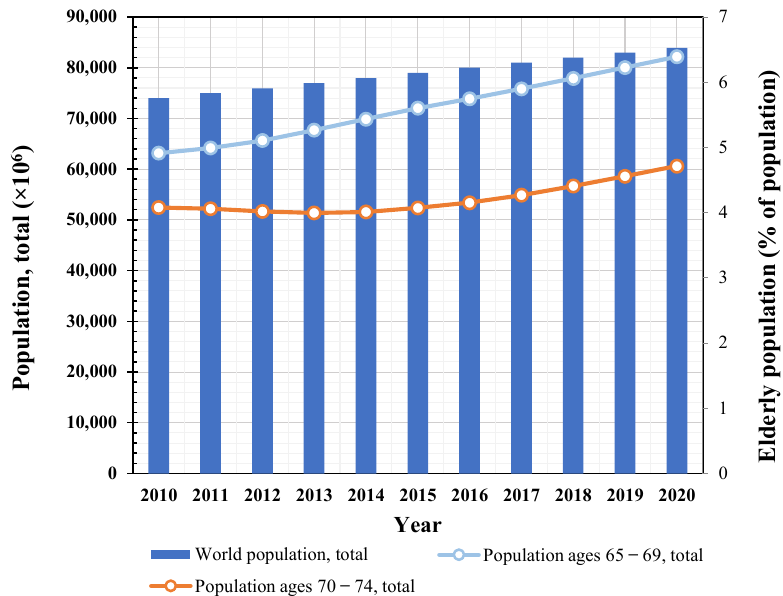
Figure 1. Growing global population and elderly population ratio.